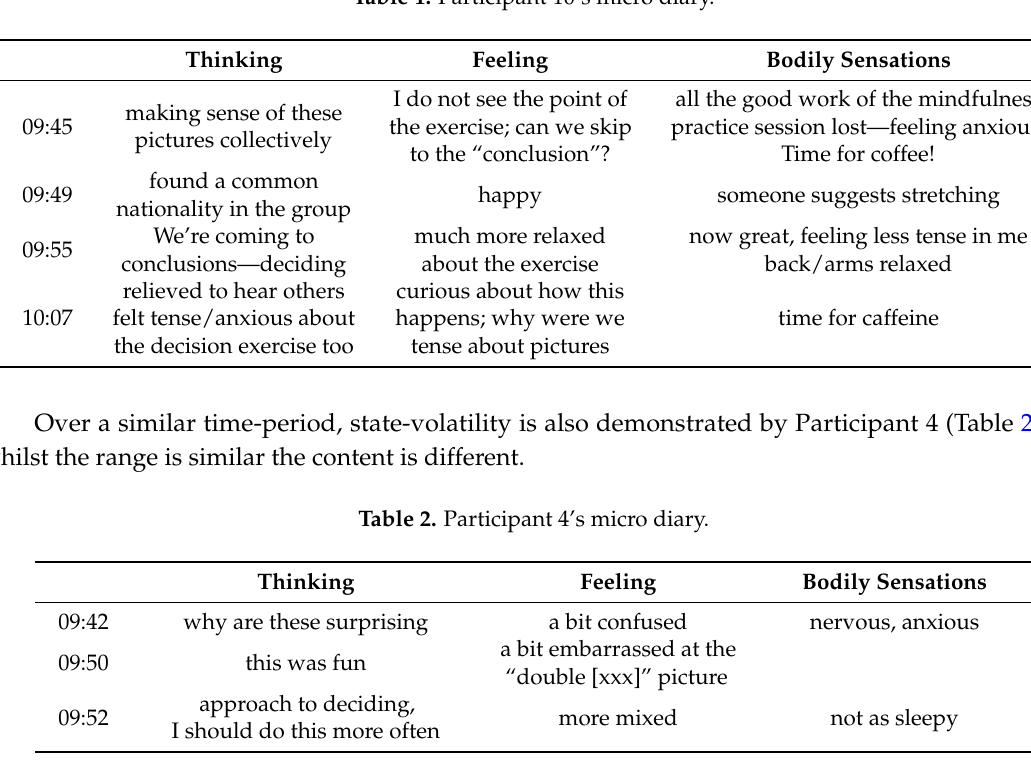
Table 1. Participant 10’s micro diary.